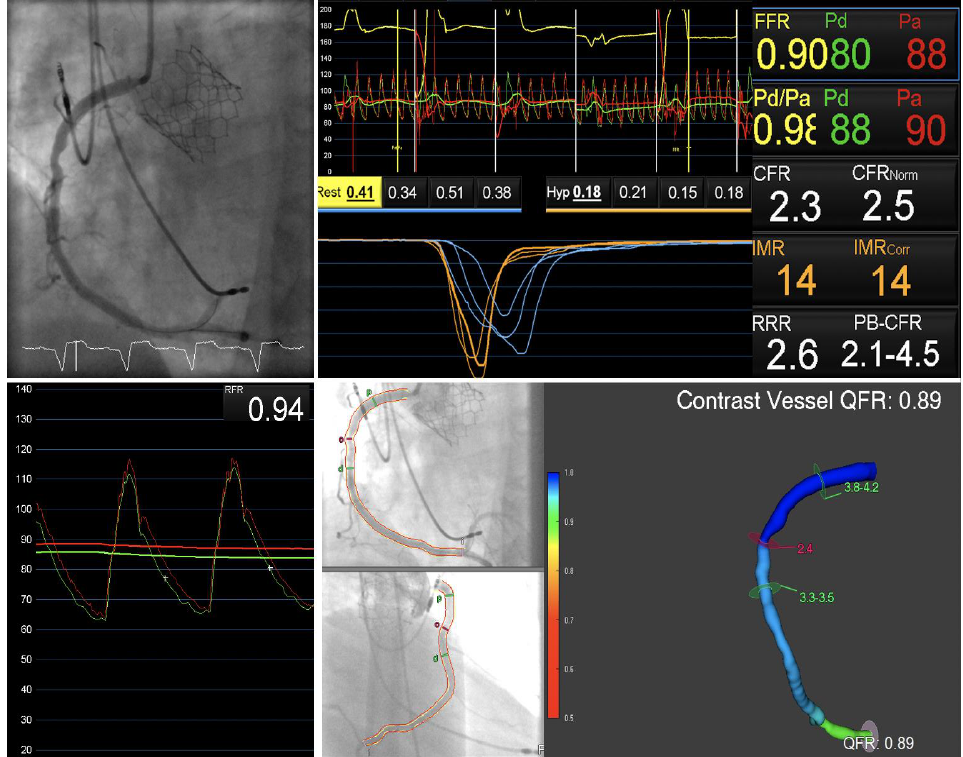
Figure 2. Functional assessment after TAVI implantation. Explanatory case showing the feasibility of performing functional assessment after valve implantation (Sapien 3, 26 mm, Edwards Lifesciences, Irvine, CA, USA) in a patient with moderate atheroma on the right coronary artery. This approach has the advantage of avoiding misleading interpretation of physiological indices in presence of Scheme 0. IMR was 14 U suggesting non inducible ischemia and preserved microvascular resistance. Below: RFR, a non-hyperemic full cycle pressure-wire based index, was 0.94 and three-dimensional (3D) quantitative coronary analysis and subsequent QFR computation was 0.89. Abbreviations: FFR, fractional flow reserve; QFR, quantitative flow ratio; IMR, index of micro-vascular resistance; RFR, resting full cycle ratio.